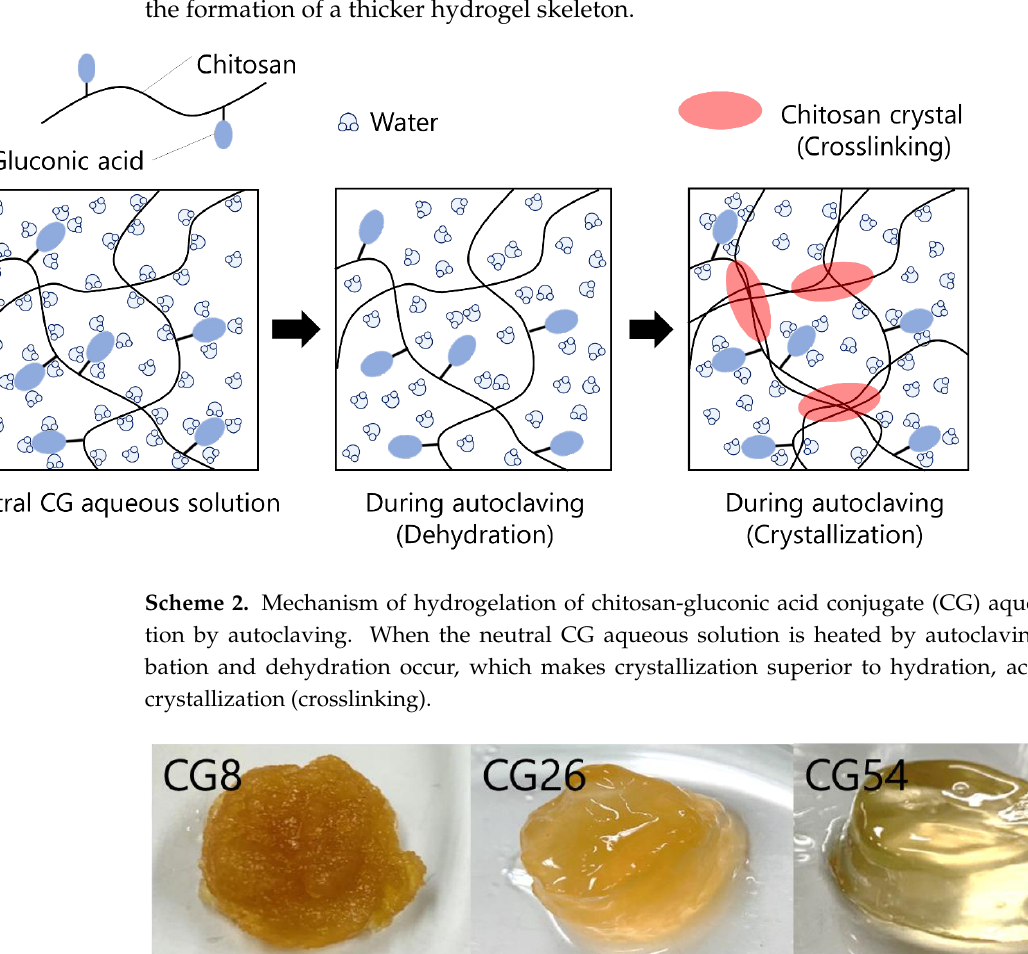
Scheme 2. Mechanism of hydrogelation of chitosan-gluconic acid conjugate (CG) aqueous solution